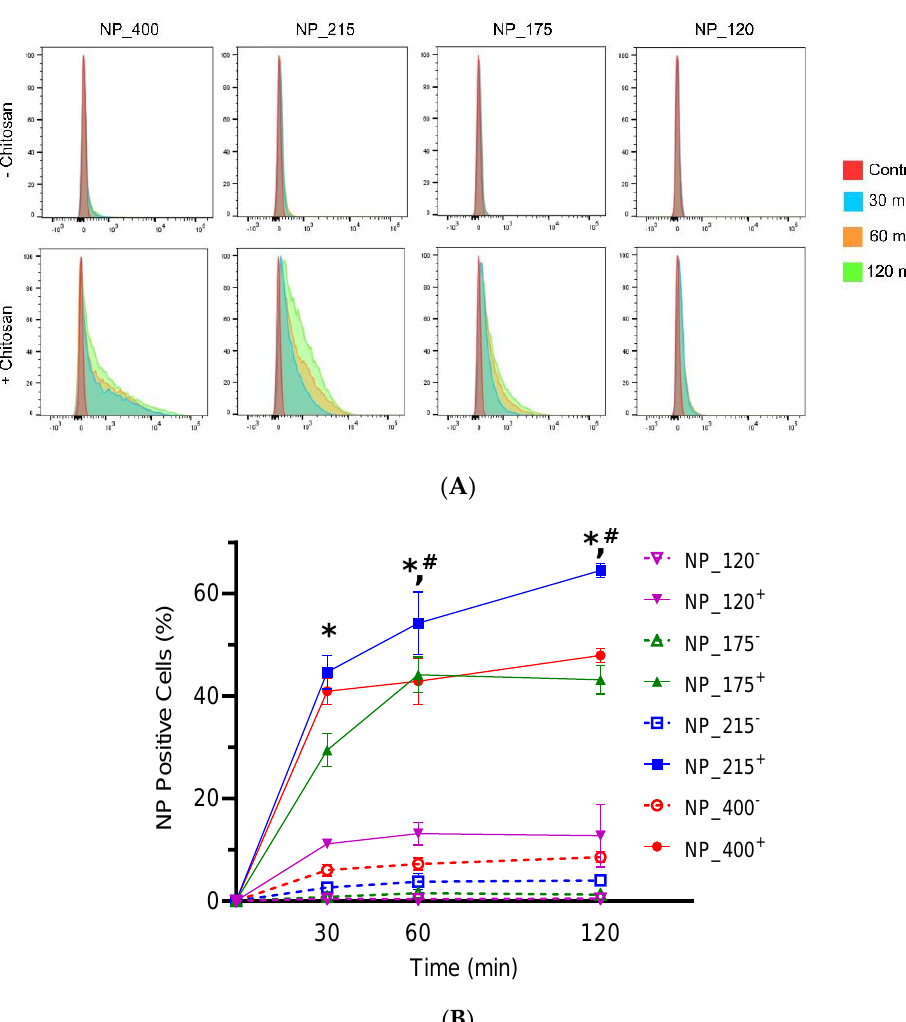
Figure 4. Adhesion of eight unique nanoformulations to mucosal epithelial cells. ( A ) Overlaid flow cytometry profiles of percent fluorescent cells at 30, 60, and 120 min for 400, 215, 175, and 120 nm PLGA NPs without (top panels) and with (bottom panels) chitosan, as indicated. ( B ) Quantification of percentage of NP positive cells at 30, 60, and 120 min. Data shown are mean ± SD, n = 4. * p < 0.05 for each NP + vs. NP - formulation of the same size at indicated time point; # p < 0.05 NP_215 + vs. all other conditions at indicated time point.